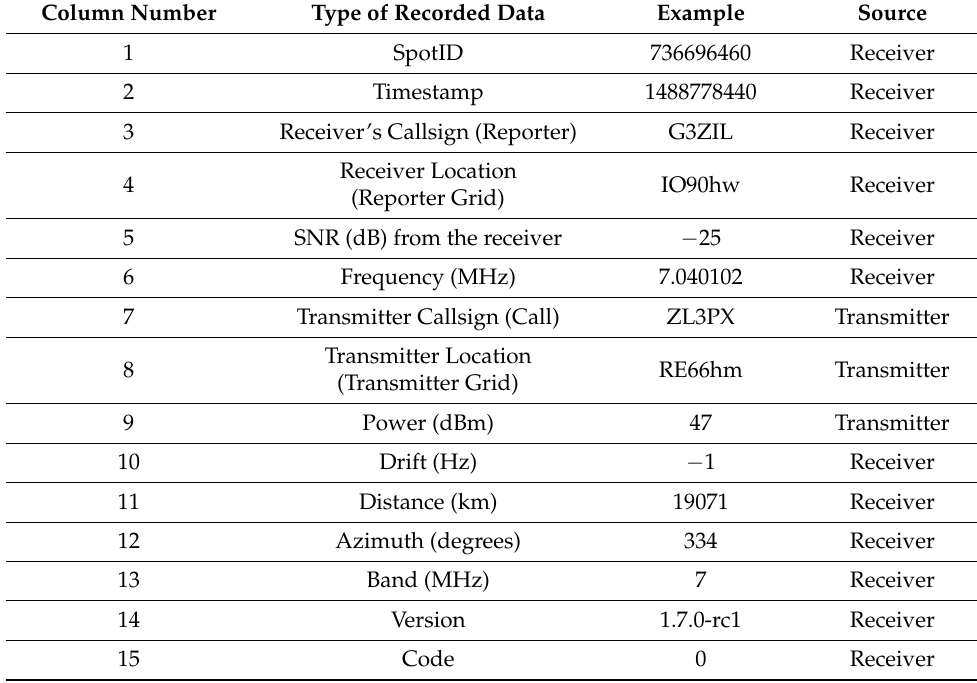
Table 2. WSPR data columns and the type of the recorded data. Column